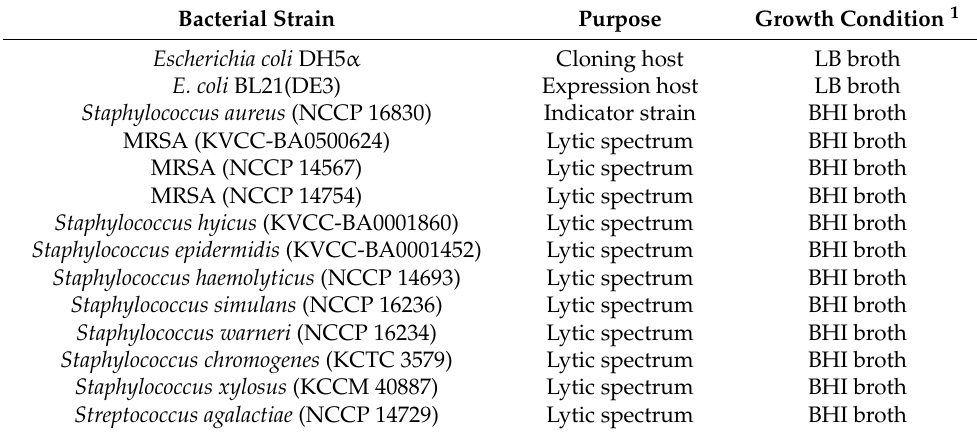
Figure 5. Lytic activity of LyJH1892 against Staphylococcus aureus (NCCP 16830) at various ( a ) pH levels, ( b ) temperatures, ( c ) NaCl concentrations, and ( d ) metal ion additions. Data are shown as means ± standard deviation of triplicate assays. In Figure 5d, None, pure LyJH1892; EDTA, purified LyJH1892 after incubating with 5 mM ethylenediaminetetraacetic acid (EDTA); Metal ion (Ca 2+ , Mg 2+ , Mn 2+ , or Zn 2+ ), LyJH1892 after adding 10 mM metal ions to EDTA-treated LyJH1892. Bars with different superscript letters (a–c) indicate a significant difference ( p < 0.05). Table 3. Bacterial strains and growth